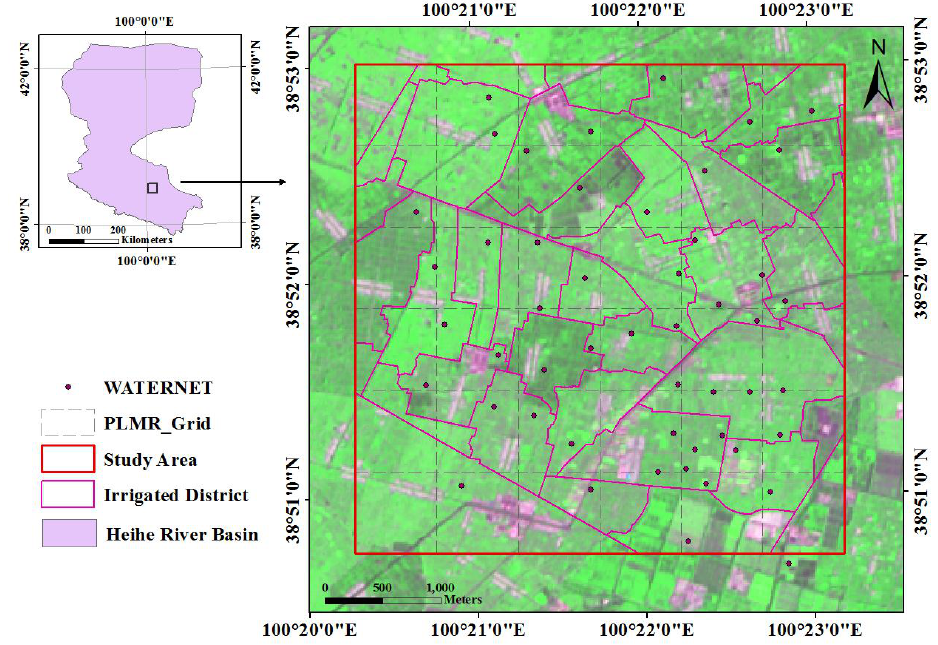
Figure 1. Overview of the study area and soil-moisture monitoring network. The right image is the ASTER L1B VNIR image covering the study area on 24 June 2012. The RGB components are channels 1 (0.56 μm), 3 (0.81 μm), and 2 (0.66 μm), respectively, with 15 m resolution.